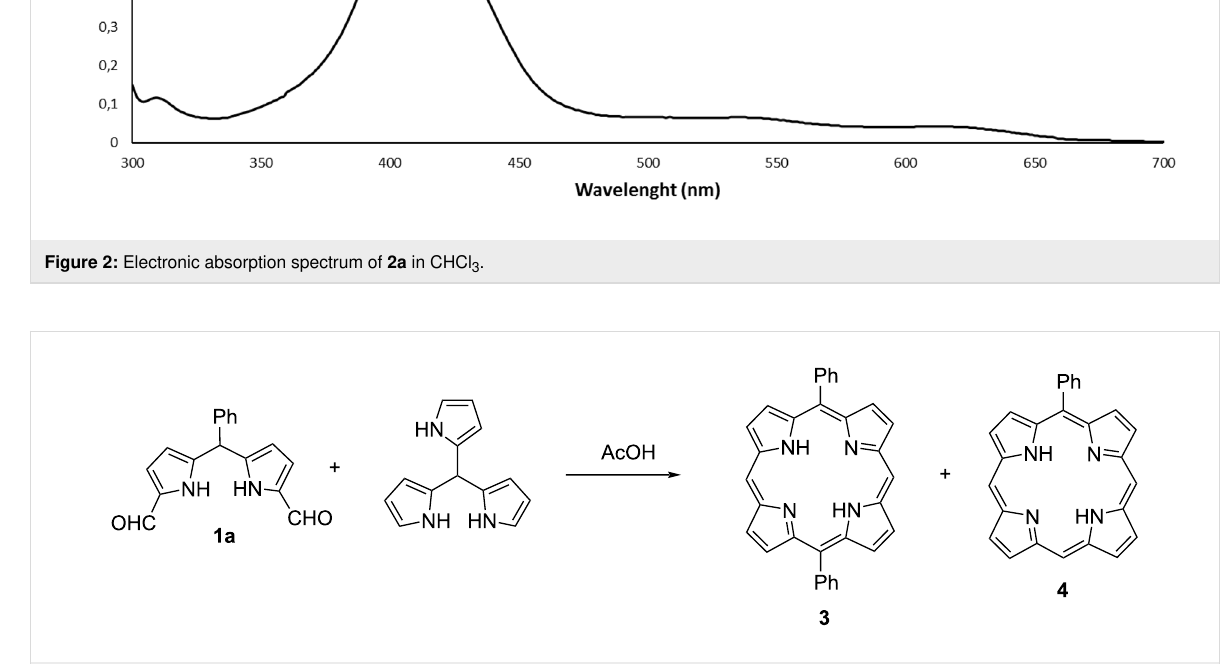
Scheme 3: [2 + 2] Mac Donald type condensation